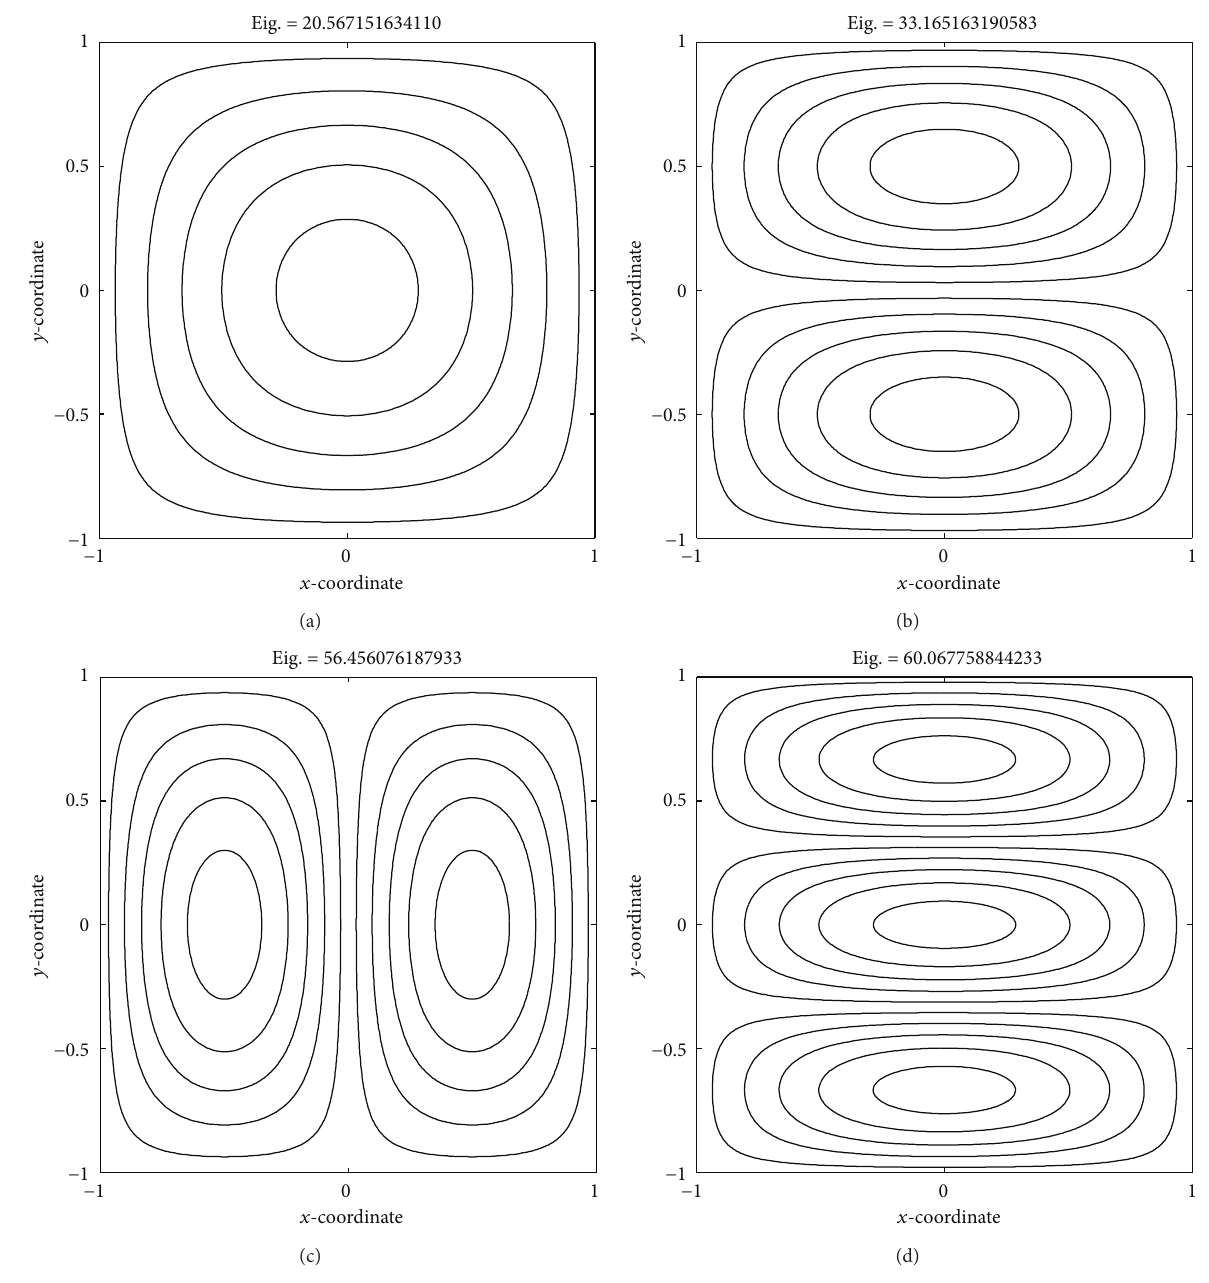
Figure 4: The first 4 vibrational modes of cross-ply laminated spherical shells, 𝜔 = 𝜔(𝑎 2 /ℎ)√𝜌/𝐸 2 , for laminate ( [0 ∘ /90 ∘ /90 ∘ /0 ∘ ] ) using a grid of 21 × 21 points, for 𝑎/ℎ = 100 , 𝑅/𝑎 = 10